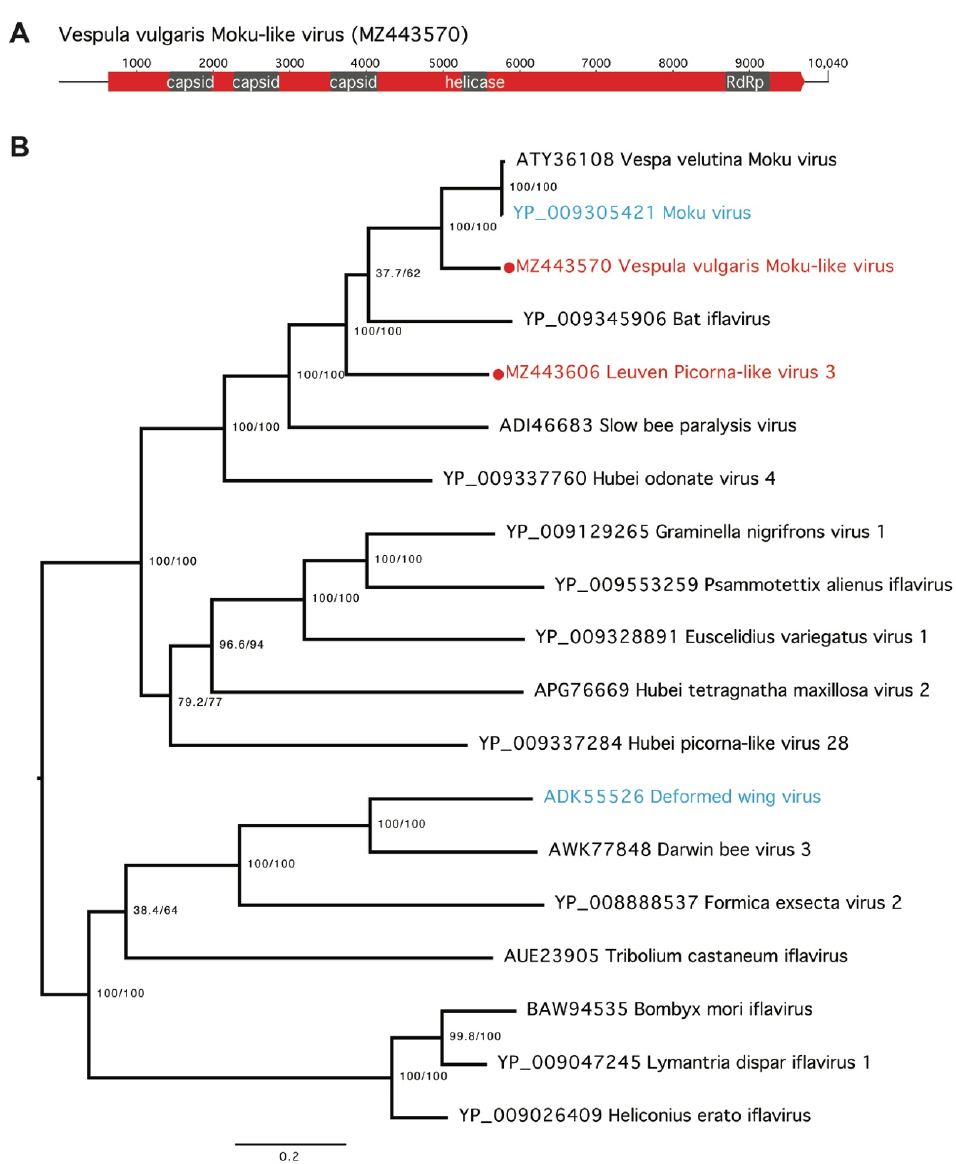
Figure 4. Vespula vulgaris Moku-like virus. ( A ) The 10,040-nucleotide genome contains one predicted large open reading frame (red). Conserved functional domains are indicated in grey. ( B ) Maximum likelihood phylogenetic tree of amino acid sequences of 19 selected Picorna viruses from the Iflaviridae on GenBank, with Vespula vulgaris Moku-like virus and another novel Picorna virus indicated (red). Known viruses also present in our samples are indicated in blue. The phylogenetic tree was generated in IQ-TREE, with the LG + F + I + G4 substitution model, which had the optimal BIC score as determined by ModelFinder Branch supports were estimated using ultrafast bootstrap approximation (UFBoot) using 1000 replicates.